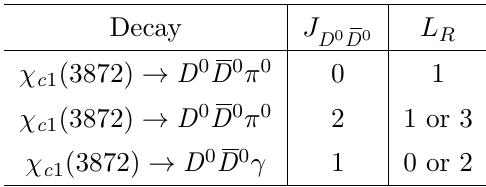
Table 1. Allowed angular momentum configurations for J